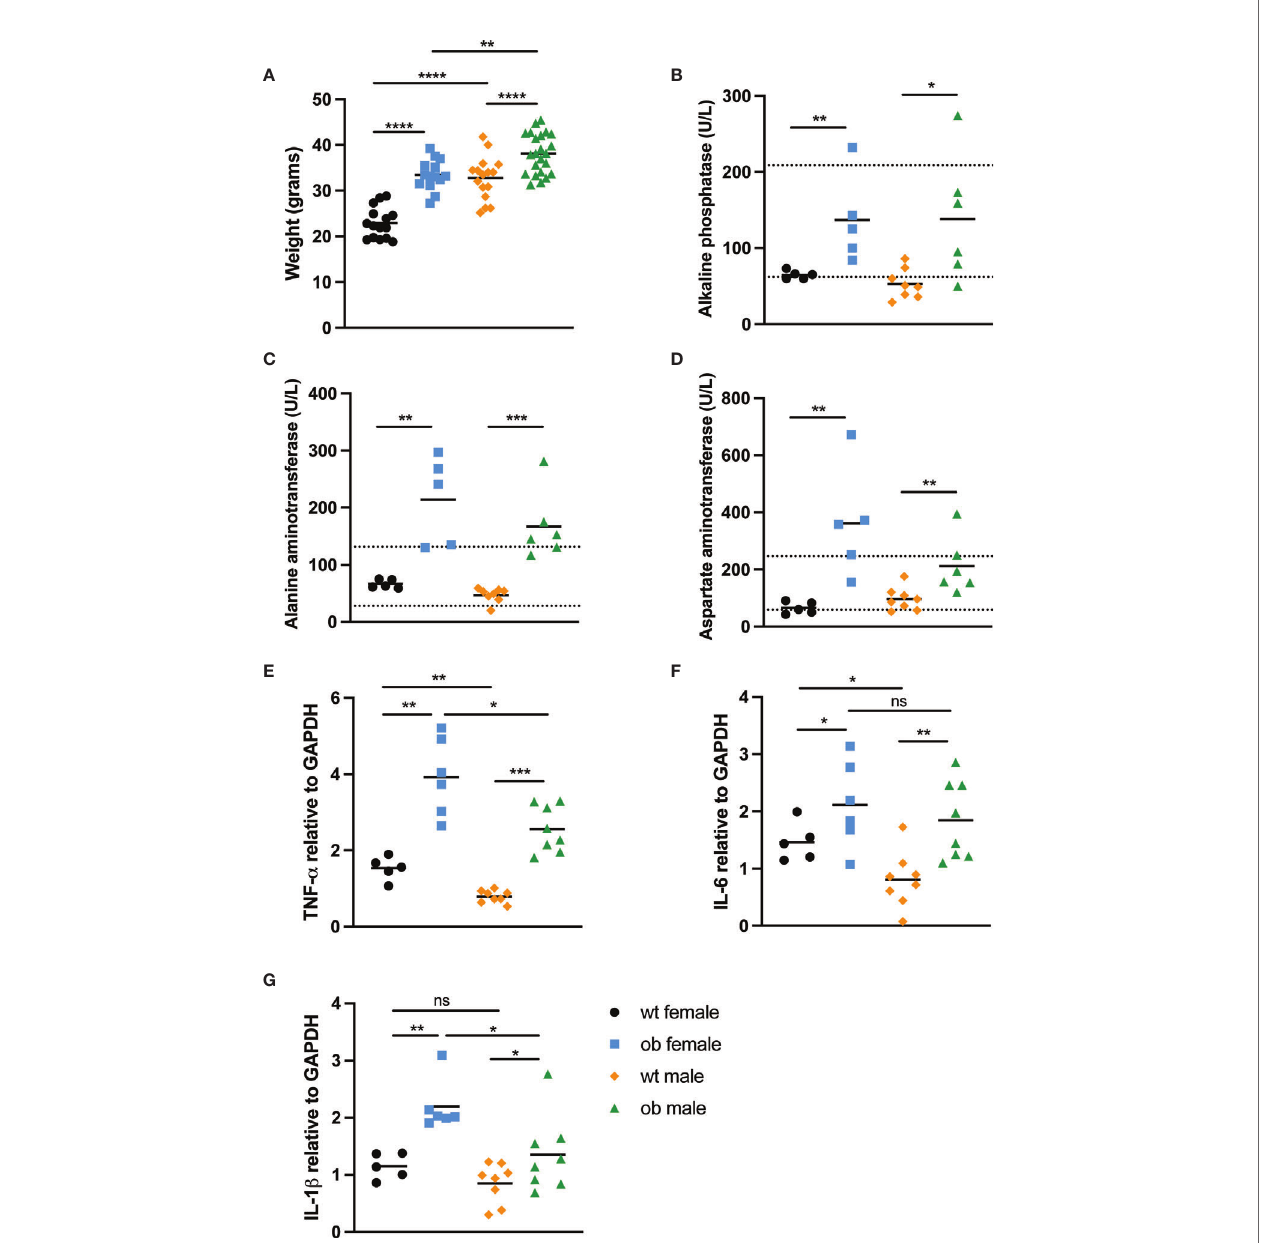
FIGURE 1 | Diet-induced obese mice experience liver damage and have elevated levels of circulating in fl ammatory cytokines. (A) Weights at time of infection. To ensure mice fed the high fat diet were obese prior to infection, female (wt n=28 and ob n=27) and male (wt n=20 and ob n=27) mice were weighed. Both female and male ob mice weighed signi fi cantly more than wt counterparts (p<0.0001). (B – D) Serum liver enzyme levels. Liver function was monitored by measuring serum levels of (B) alkaline phosphatase (ALKP), (C) alanine aminotransferase (ALT) and (D) aspartate aminotransferase (AST) in wt female (n=5), ob female (n=5), wt male (n=8) and ob male (n=6) mice. All liver enzyme levels tested were detected at signi fi cantly higher amounts in ob mice when compared to wt mice, and numerous ob mice displayed enzyme levels outside of the normal range for a mouse (as indicated by the dotted lines). When comparing ALKP levels in ob versus wt females, p=0.0079, while p=0.0127 for ob versus wt males. When comparing ALT levels, p=0.0079 for ob versus wt females, while p=0.0007 for ob versus wt males. When comparing AST levels, p=0.0079 for ob versus wt females, while p=0.0080 for ob versus wt males. (E – G) Circulating in fl ammatory cytokine levels. qRT-PCR was used to characterize expression of three in fl ammatory cytokines, tumor necrosis factor- a (TNF- a ), interleukin-6 (IL-6) and interleukin-1 b (IL-1 b ), in the blood of naïve wt and ob female (n=5 and n=6, respectively) and male (n=8 and n=8) mice. In each instance, in fl ammatory cytokine levels were signi fi cantly higher in ob mice when compared to wt counterparts. Additionally, overall, in fl ammation was higher in female mice when compared to male mice. (E) TNF- a expression: p=0.0043 for ob versus wt females, p=0.0047 for ob versus wt males, p=0.0080 for ob females versus ob males and p=0.0109 for wt female versus wt males. (F) IL-6 expression: p=0.0303 for ob versus wt females, p=0.0045 for ob versus wt males, p=0.0533 for ob females versus ob males and p=0.0109 for wt female versus wt males. (G) IL-1 b expression: p=0.0303 for ob versus wt females, p=0.0499 for ob versus wt males, p=0.0127 for ob females versus ob males and p=0.0109 for wt female versus wt males. Statistical signi fi cance was determined by Mann-Whitney test. *p < 0.05, **p < 0.01, ***P < 0.001, ****p < 0.0001, ns, not signi fi